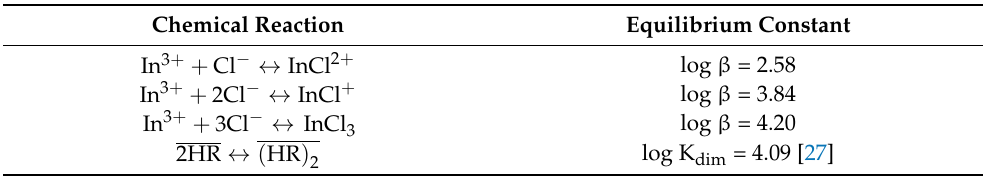
Table 2. Chemical reaction considered in the numerical evaluation of the extraction equilibria by the LETAGROP–DISTR program. Chemical Reaction Equilibrium Constant